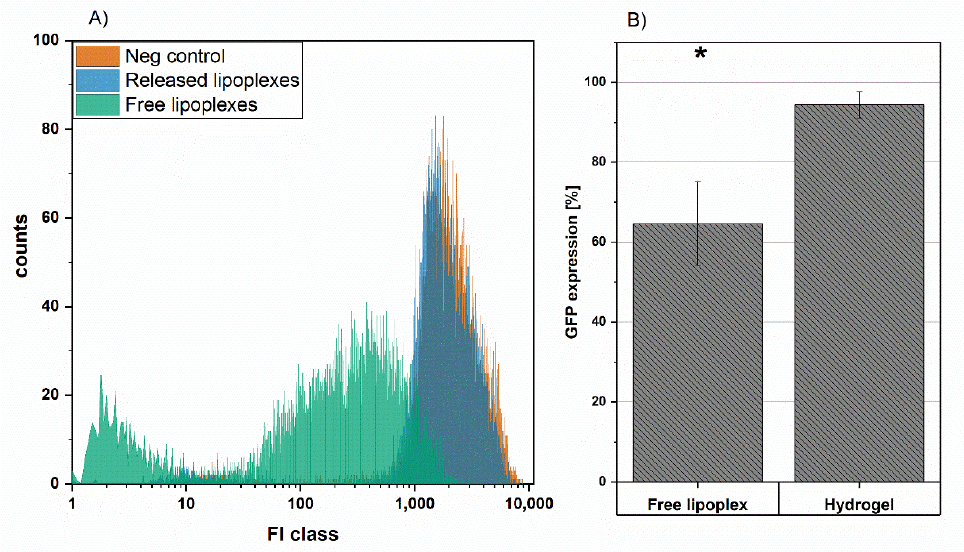
Figure 9. ( A ) FACS intensity histogram and ( B ) resulting mean GFP knockdown of free lipoplexes compared to hydrogel released carrier, the negative controls represent 100% of the GFP expression. * corresponds to a statistical significance of p < 0.05.